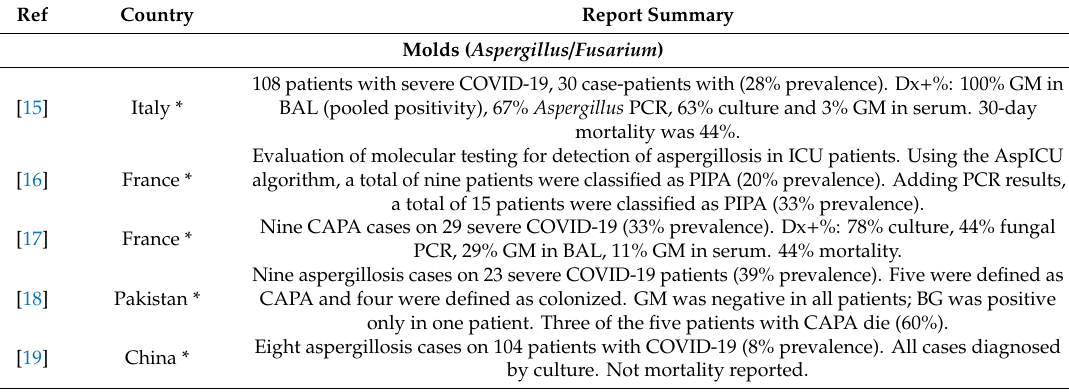
Table 1. Results of the literature review on fungal diseases and